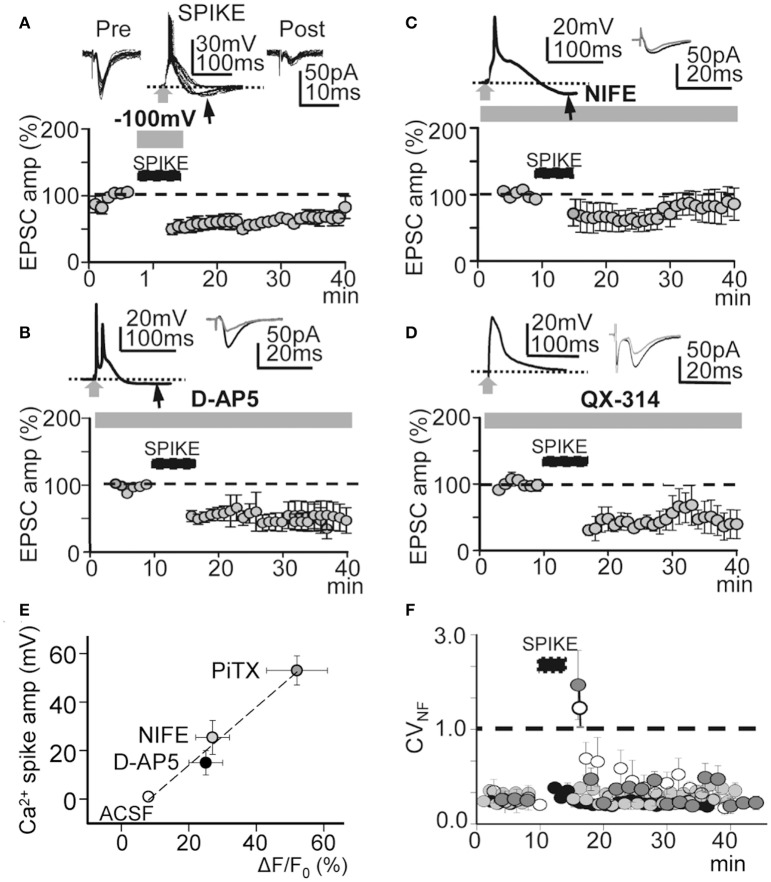
Effects of hyperpolarization and NMDAR, L-type VGCC, and voltage-gated Na+ conductance blockade. (A), upper. Superimposed records of pre-induction EPSCs (n = 20), Ca2+ spikes during hyperpolarization to −100 mV (n = 20) and post-induction EPSCs (n = 10). (A), lower. Same as Figure 4A, but LTD was induced with hyperpolarization to -100 mV during the INDUCTION process (N = 5, P < 0.001). (B) Same as (A), but the LTD was induced under inhibition of NMDARs with D-AP5 (50 μM, N = 6, P < 0.001). (C) Same as (A), but LTD induced under nifedipine (20 μM) inhibition of L-type VGCC (N = 5, P < 0.001). (D) Same as (A), but the LTD was induced by intracellular QX-314 (5 mM in the pipette solution) inhibition of voltage gated Na+ conductance (N = 6, P < 0.001). (E) Plot of the Ca2+ spike amplitude in function of the cytosolic peak somatic Ca2+ signal recorded in control ACSF (open circle) and when PiTX (dark gray circle), nifedipine (gray circle) and D-AP5 (black circle) were added. Note the linear correlation (r2 = 0.98) indicating a close association between the amplitude of Ca2+ spikes the cytosolic Ca2+ signal. (F) Time course of the noise free coefficient of variation (CVNF) calculated form the experiments under intracellular QX-314 (white circles), nifedipine (dark gray circles), D-AP5 (light gray circles) and during hyperpolarization to −100 mV (black circles). Note the lack of long term modifications of the CVNF in all conditions tested. Black arrows in (A–C) indicate hyperpolarizations following Ca2+ spikes.